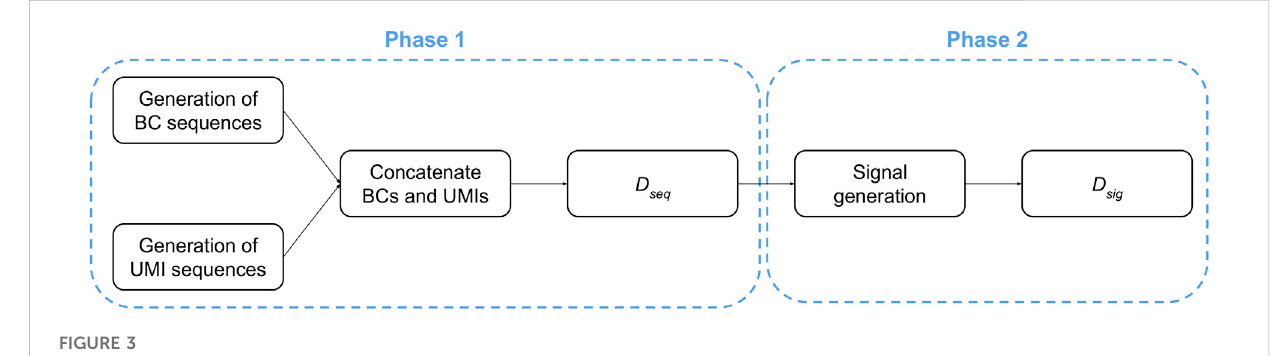
FIGURE 3 Work fl ow used for in silico generation of ONT-like